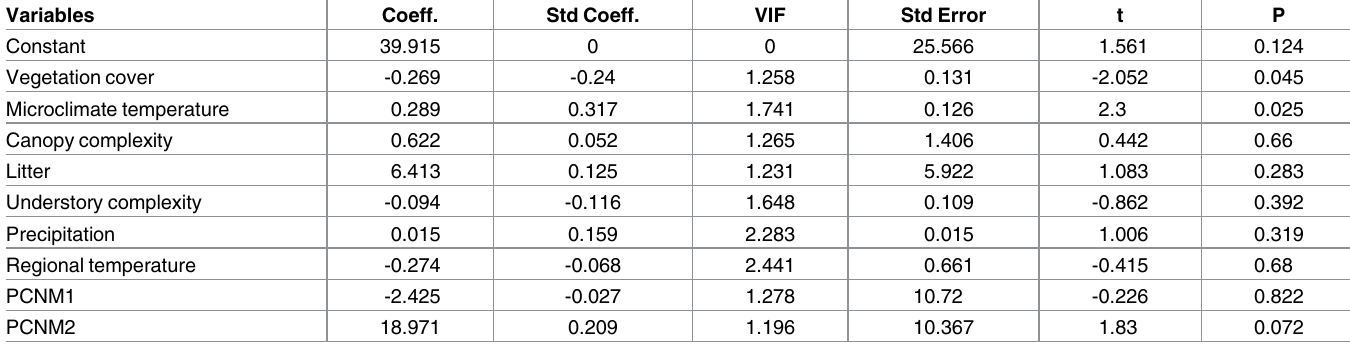
Table 3. Result multiple regression of species richness and environmental variables in Caatinga areas, in the Serra da Capivaraand Serra das Confus õ es National Parks, state of Piauı´, Brazil. Variables